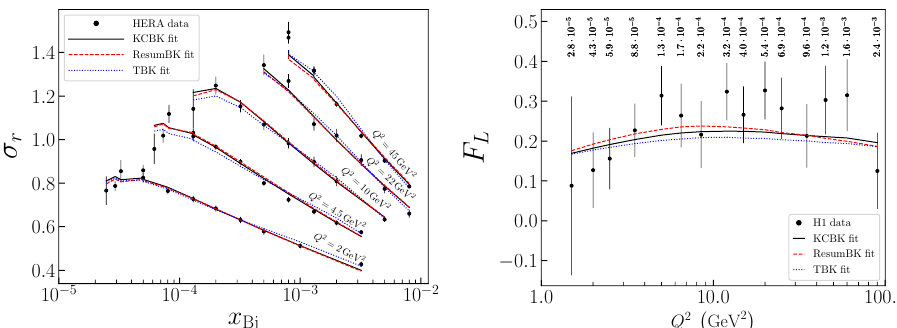
Figure 13. Comparison of the CGC at NLO compared to HERA data. ( Left ) Reduced cross section at small- x . ( Right ) F L structure function. Figure from the work in [61].